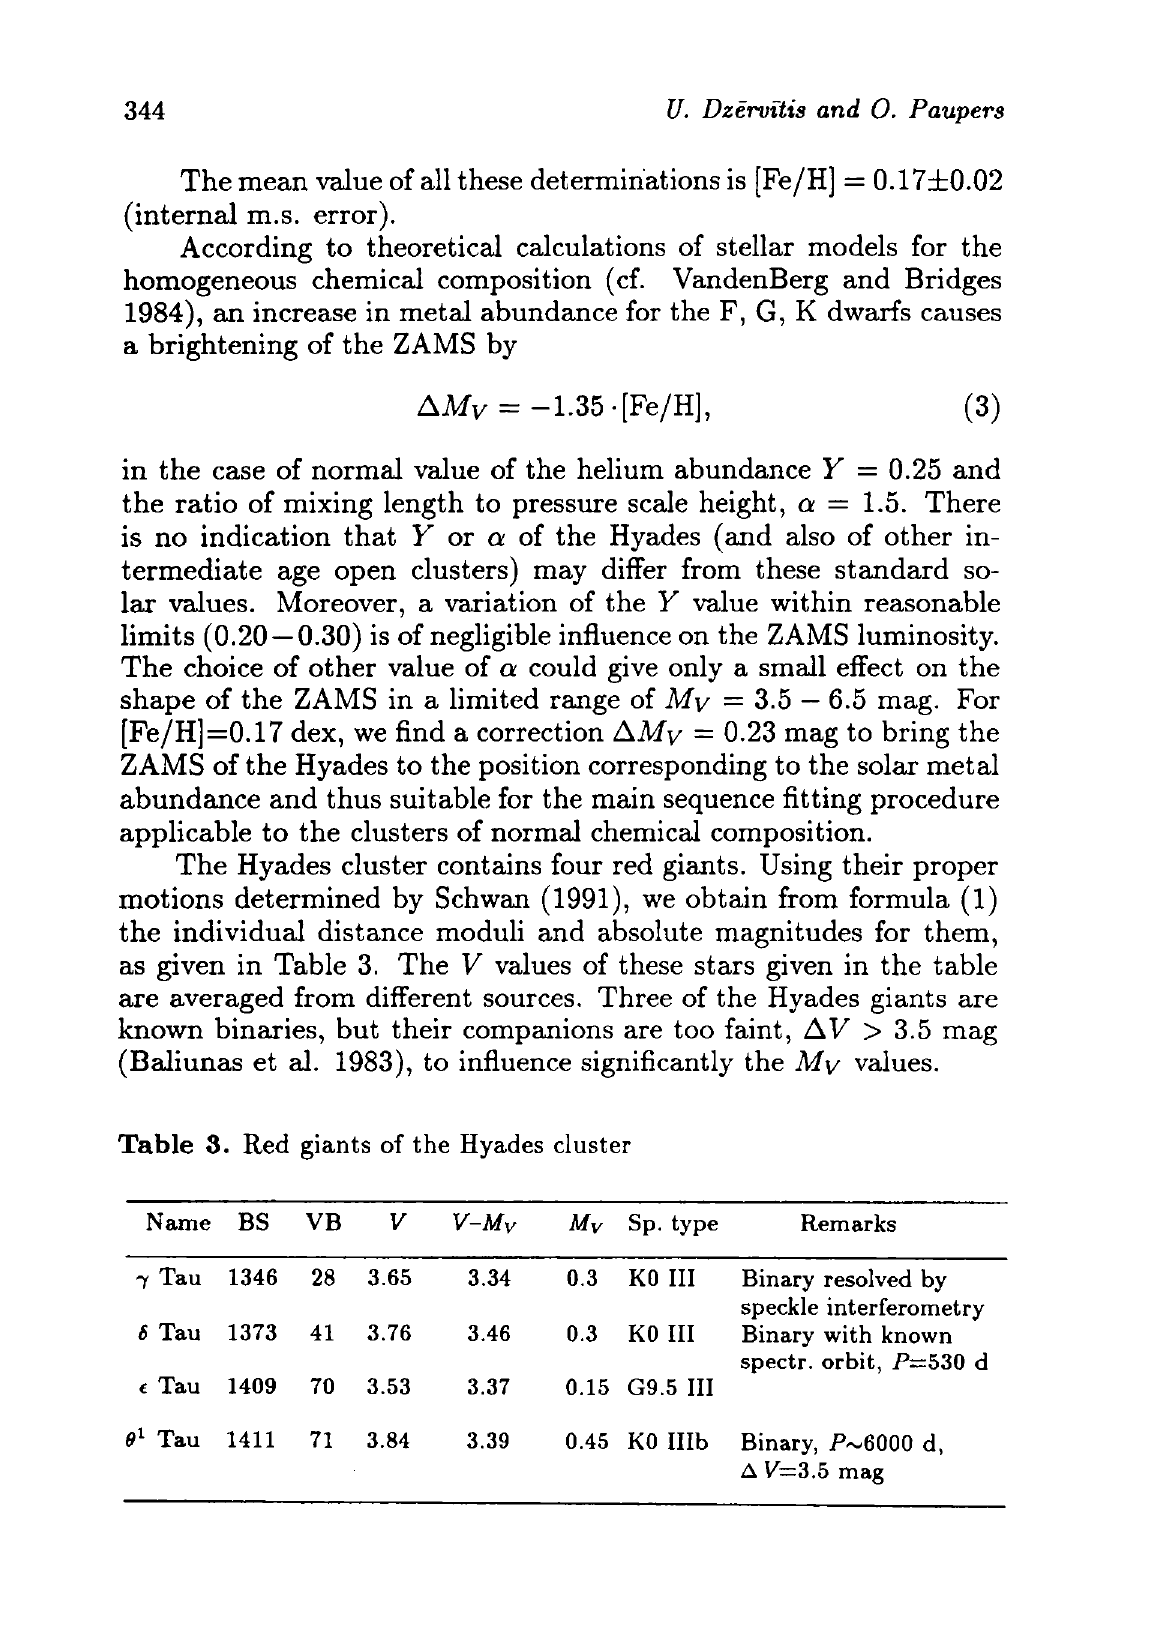
Table 3. Red giants of the Hyades